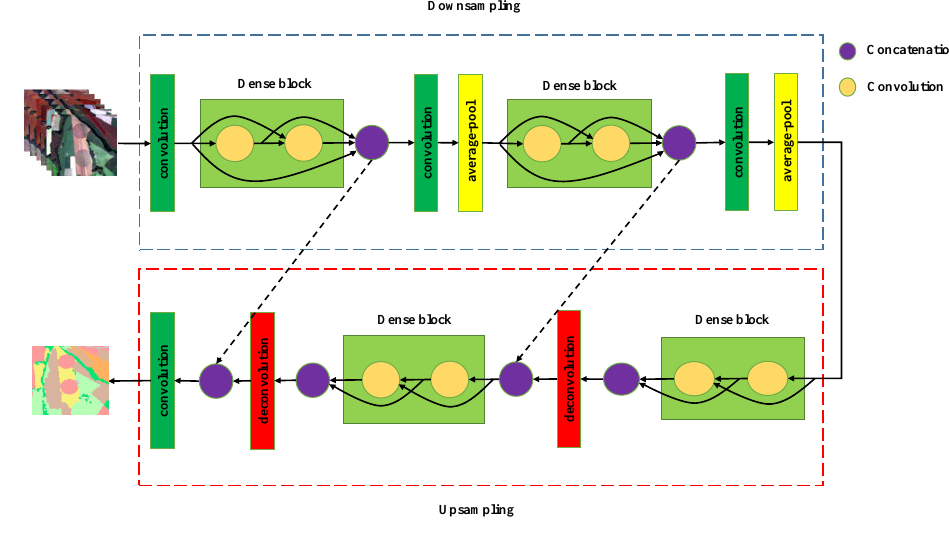
Figure 7. FCNpixel